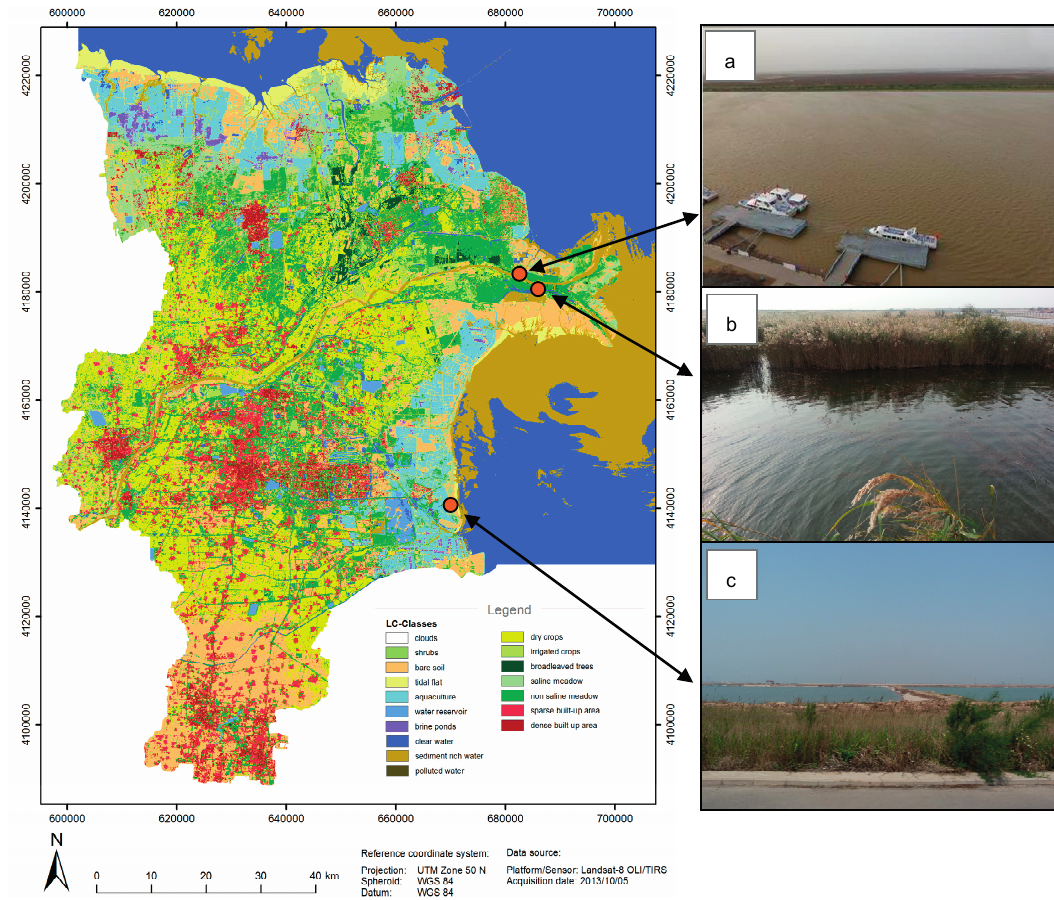
Figure 3. Landsat-8 derived land use classification for 2013 (kindly provided by M. Ottinger), as well as field photographs from 2013. ( a ) Yellow River mouth area; ( b ) wetlands; ( c )